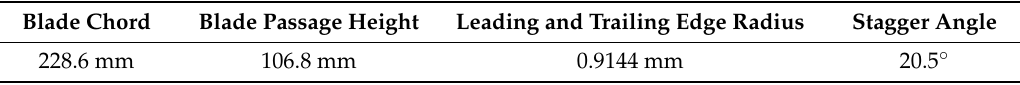
Figure 1. Blade passage geometry cascade. Table 1. Double Circular Arc (DCA) compressor blade geometrical characteristics.